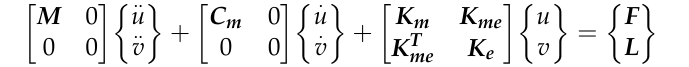
Figure 3. The finite element model of QCM with dot finger electrode. 3.1. Single Finger Electrode The electrode structure of single finger is shown in Figure 2a. In order to analyze the effect of size and position of finger on vibration displacement and obtain the optimal size proportion, five groups of different sizes of finger width 𝑎 (cid:2870) are selected for simulation, and their widths 𝑎 (cid:2870) are 2.3, 1.9, 1.5, 0.9 and 0.3 mm, respectively. Figure 4a shows the normalized displacement distribution in 𝑋 (cid:2869) direction of quartz surface on electric shaft 𝑋 (cid:2869) with different 𝑎 (cid:2870) at the corresponding fundamental resonant frequency. When the finger occupies the main area of single-finger electrode, the displace- ment distribution starts to appear in double peaks, but the overall distribution is mainly Gaussian shape. As 𝑎 (cid:2870) decreases, the amplitude of vibration displacement decreases and turns to a more obvious bimodal gradually. This is because the intensity of energy capture decreases with the mass effect of finger electrode decreases. When 𝑎 (cid:2870) is about 1.5 mm, that is, the proportions of finger width and outer contour radius of the electrode is about 0.6, the displacement distribution is relatively uniform while amplitude can be maintained at a certain level. The vibration displacement nephogram is shown in Figure 4b. It can be seen that the finger is too narrow to capture vibration energy in fully electroplated region when 𝑎 (cid:2870) is 0.3 mm. In this case, the vibration energy is mainly captured in center by the circular electrode at bottom, which is the main producer of mass effect, and the vibration displacement is a simple convex distribution with a minute amplitude. Although the vi- bration displacement distribution of the finger electrode is uneven, it provides a design basis for the multi-finger electrodes.